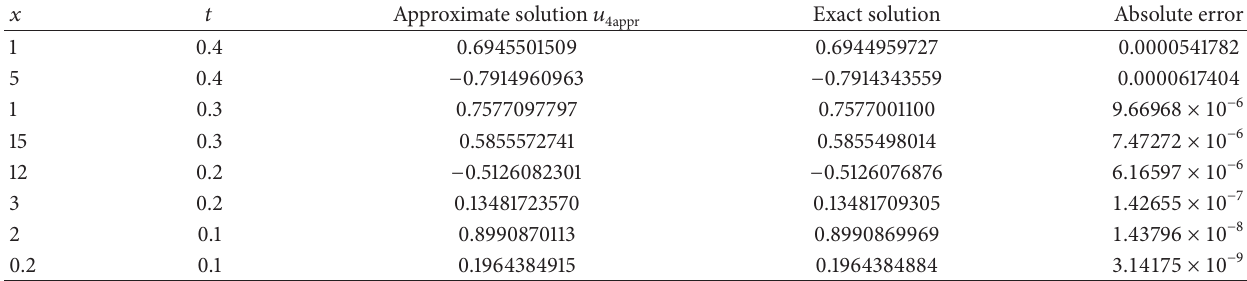
Table 1: Comparison between the real part of 𝑢 4 and 𝑢 when 𝛼 = 𝛽 = 1 .